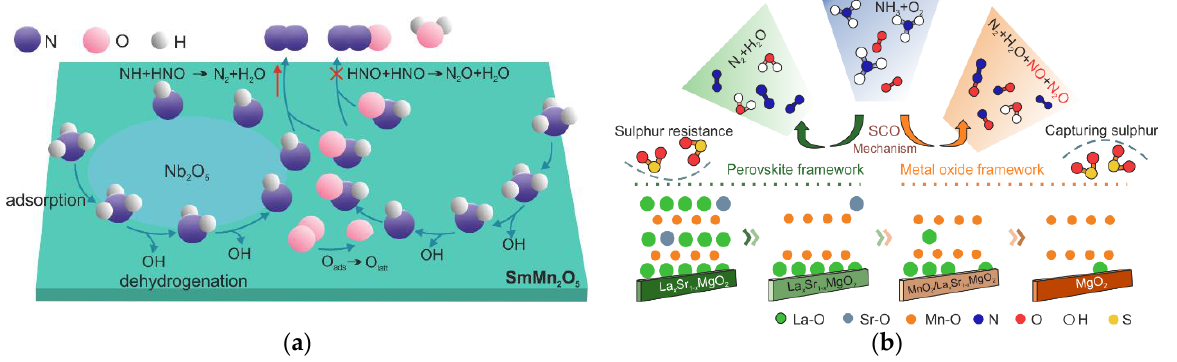
Figure 8. Schematic representation of ( a ) Nb 2 O 5 modification to enhance the N 2 selectivity of SmMn 2 O 5 . Reprinted from [108] with permission from Elsevier; ( b ) NH 3 -SCO mechanism over modified La x Sr 1- x MnO 3 perovskite. Reprinted from [110] with permission from ACS Publications.